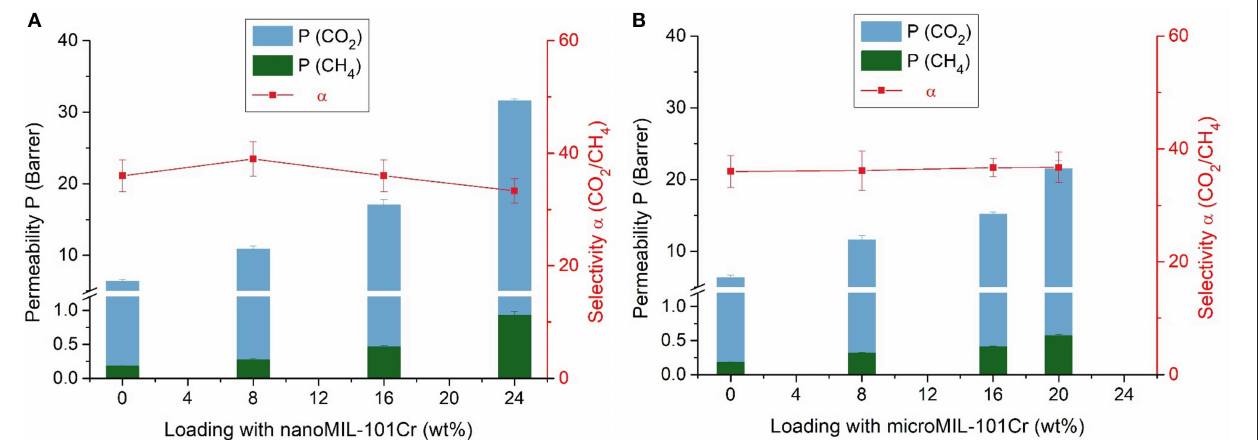
FIGURE 7 | Separation properties of nanoMIL-101Cr@Matrimid (A) and microMIL-101Cr@Matrimid (B) MMMs with different MOF loadings for a 50:50 v:v gas mixture of CO 2 and CH 4 at 25 ◦ C and a feed pressure of 4 bar. Error bars of the permeability correspond to measurement uncertainties of the three investigated membranes; error bars of the selectivity were calculated via error propagation, that is, by summation of the relative errors of the permeabilities.